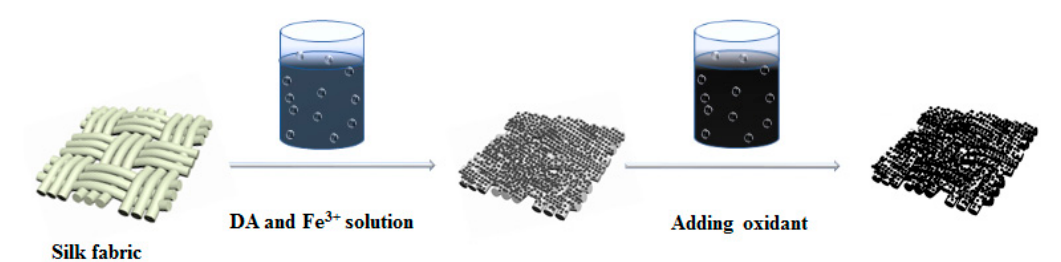
Figure 1. Schematic of dopamine (DA) silk dyeing flow process.